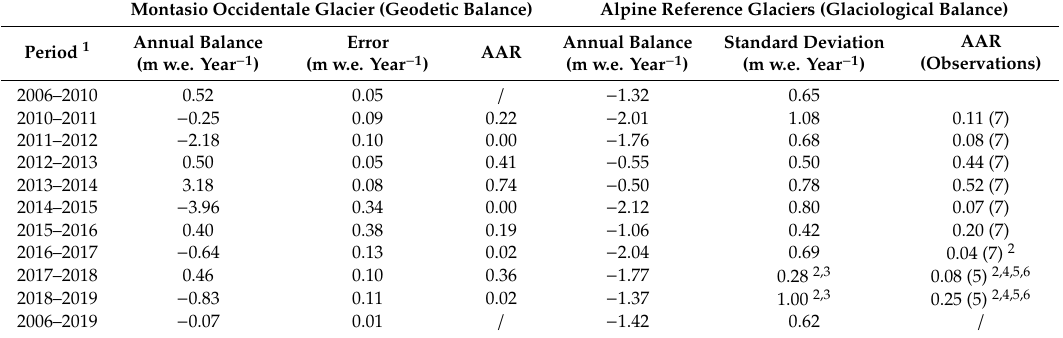
Figure 3. Annual elevation change rate for ( a ) individual years and ( b ) two sub-periods. Table 3. Comparison of annual balances and Accumulation Area Ratios (AARs) measured on the Montasio Glacier with the geodetic method, and on nine alpine reference glaciers (Sarennes, Saint Sorlin, Gries, Silvretta, Hintereis, Kesselwand, Vernagt, Careser, and Sonnblick) with the glaciological method. The mass balance data for the reference glaciers have been retrieved from Zemp et al. (2020) [50], unless otherwise